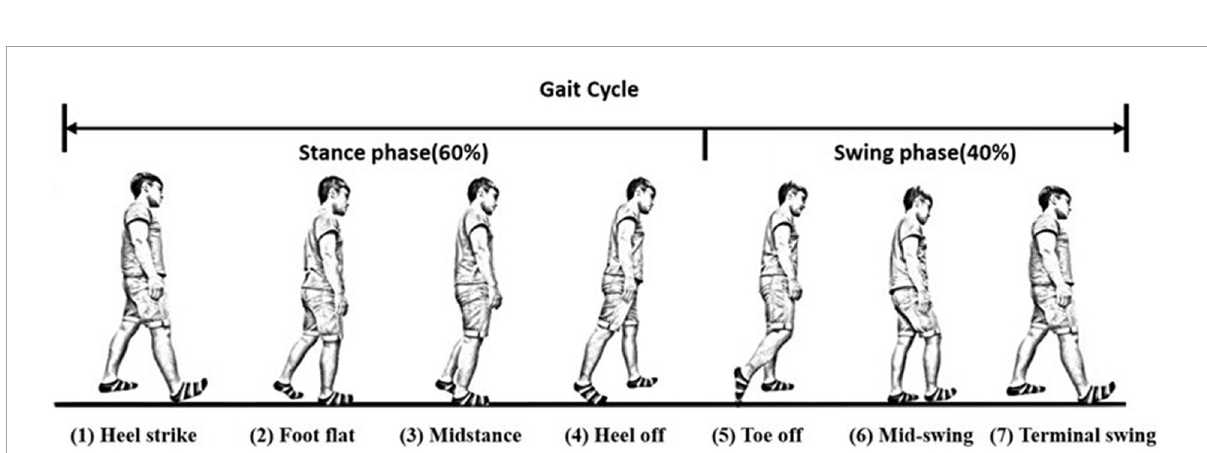
FIGURE3 A complete gait cycle. A complete gait cycle is composed of a stance phase and a swing phase, containing three important gait events in one gait cycle: the mid-swing (MS), the heel strike (HS), and the toe-off (TO). The stance phase is defined as the time interval from the HS to the TO and accounts for about 60% of the gait cycle. The swing phase takes about 40% of the gait cycle and is defined as the time interval from the TO to the next